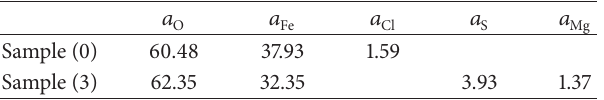
Table 1: Atomic percentages ( 𝑎 𝑖 ) determined from EDS measure- ments performed on samples ( 0 ) and ( 3